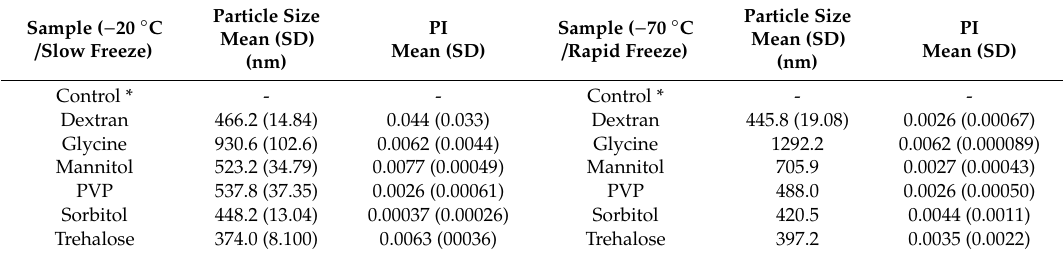
Table 5. Freeze–thaw study: E ff ect of cryoprotectant on the particle size and distribution of SLNs on reconstitution after lyophilization ( N =